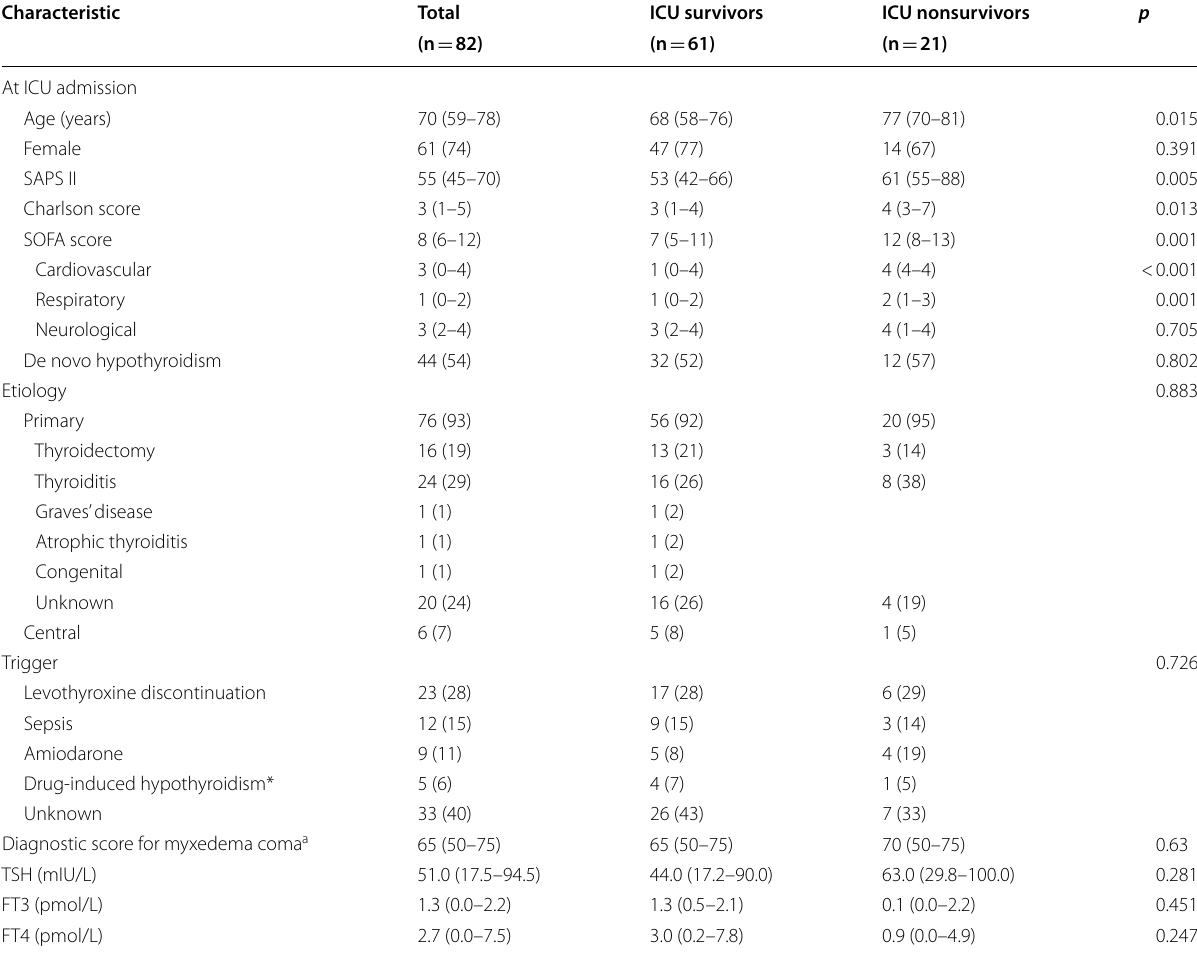
Table 1 Included patients’ general characteristics according to ICU survival